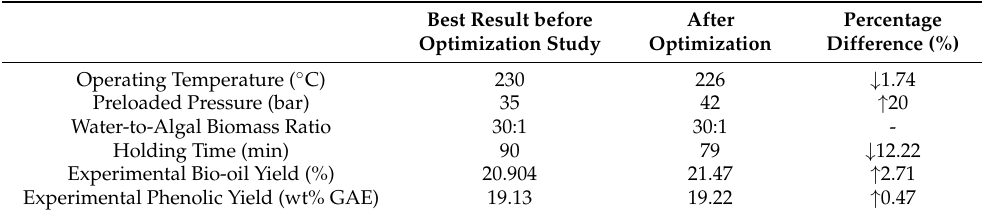
Figure 4. Diagnostic plot ( a ) residual versus experimental run and ( b ) normal plot of residuals for response, phenolic yield. Table 10. Comparison of results before and after